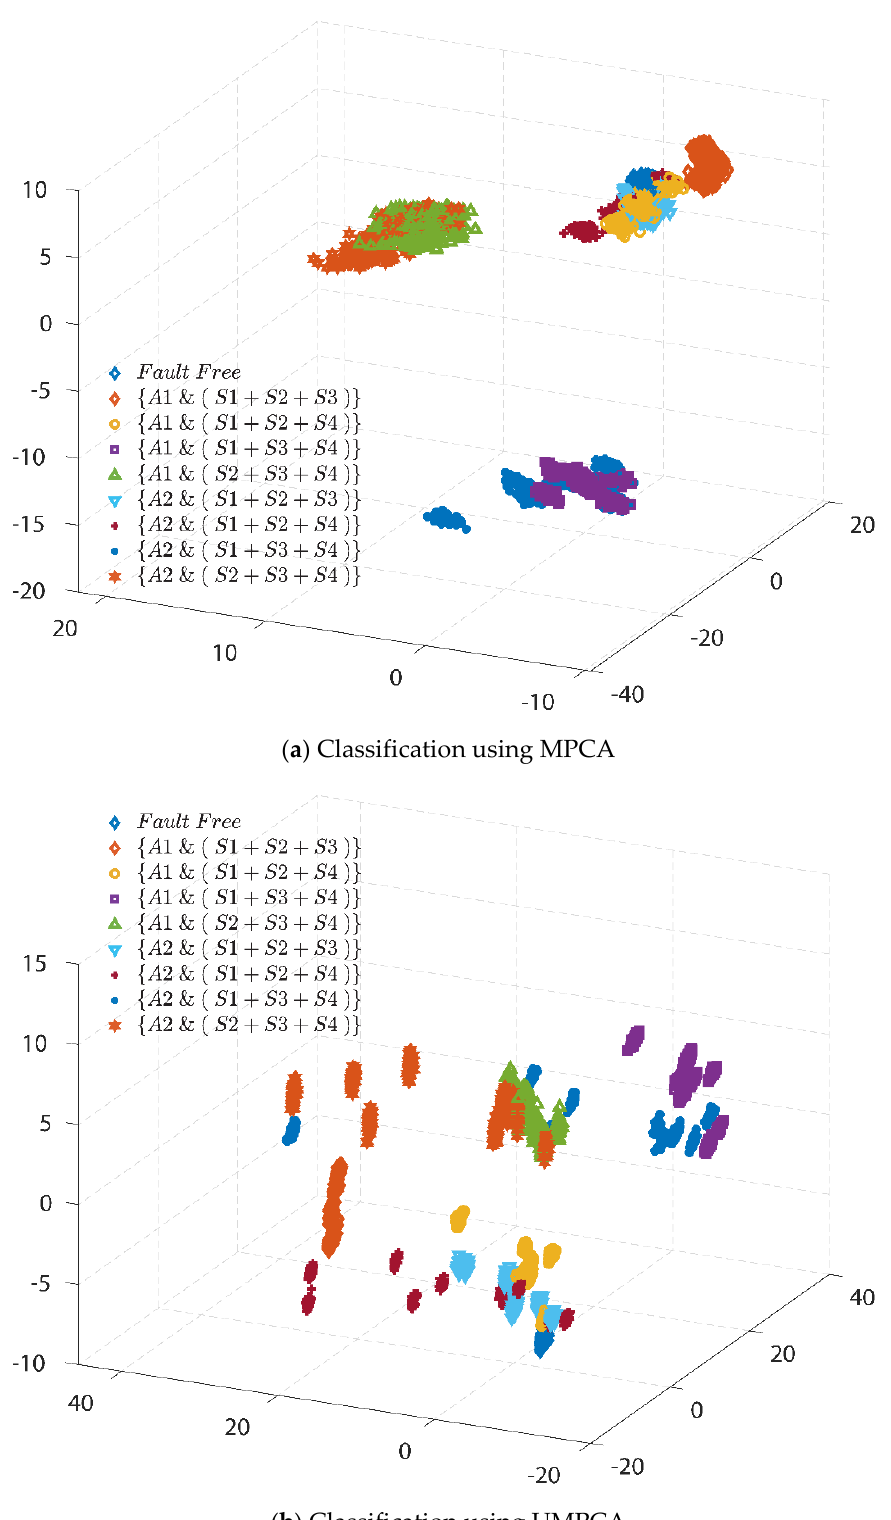
Figure 10. Three-dimensional space visualization performance for fault classification for wind turbines subjected to single actuator fault and three sensor faults under AWGN noises, using ( a ) MPCA and ( b ) UMPCA, respectively.